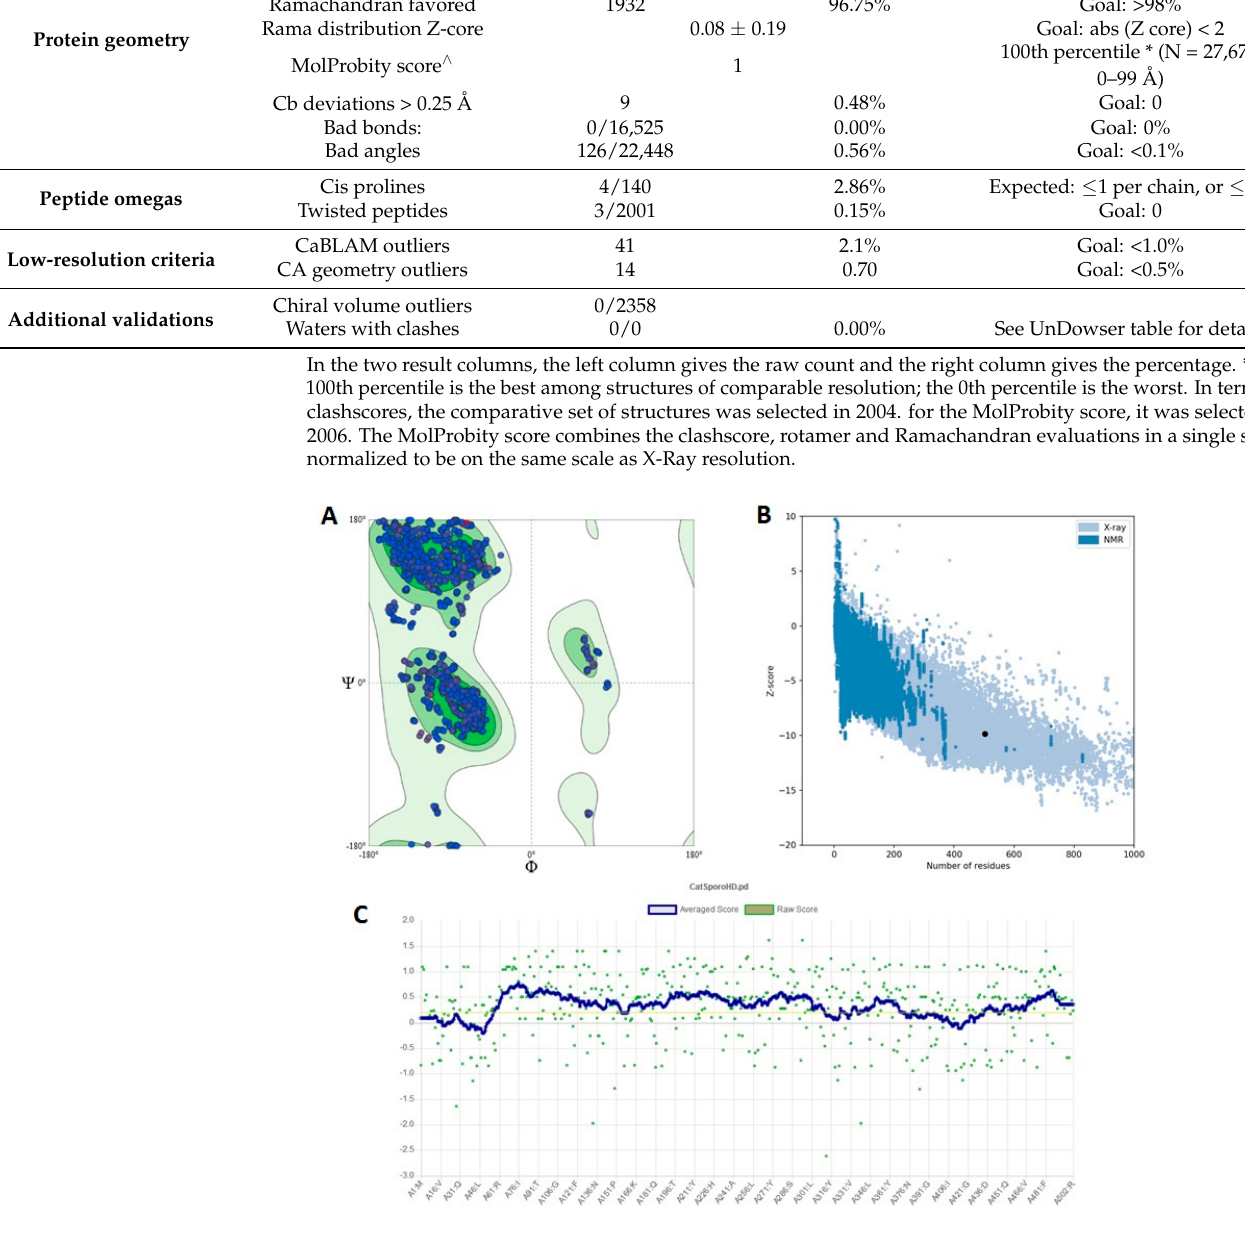
Figure 4. ( A ) Ramachandran plot of the predicted structure of S. schenckii catalase. The green regions in the plot indicate the most allowed regions, the additional allowed regions are shown in light green and the generously allowed regions are shown in gray shades. ( B ) Validation of the predicted catalase structure using the ProSA ‐ web server. The Z ‐ score in this plot is indicated by a dark black point. The structure is displayed with two distinguishable regions. The dark blue and light blue represent NMR and X ‐ ray data, respectively. ( C ) Verify3D plot of the 3D catalase model with a 3D ‐ 1D averaged score (72.37%).